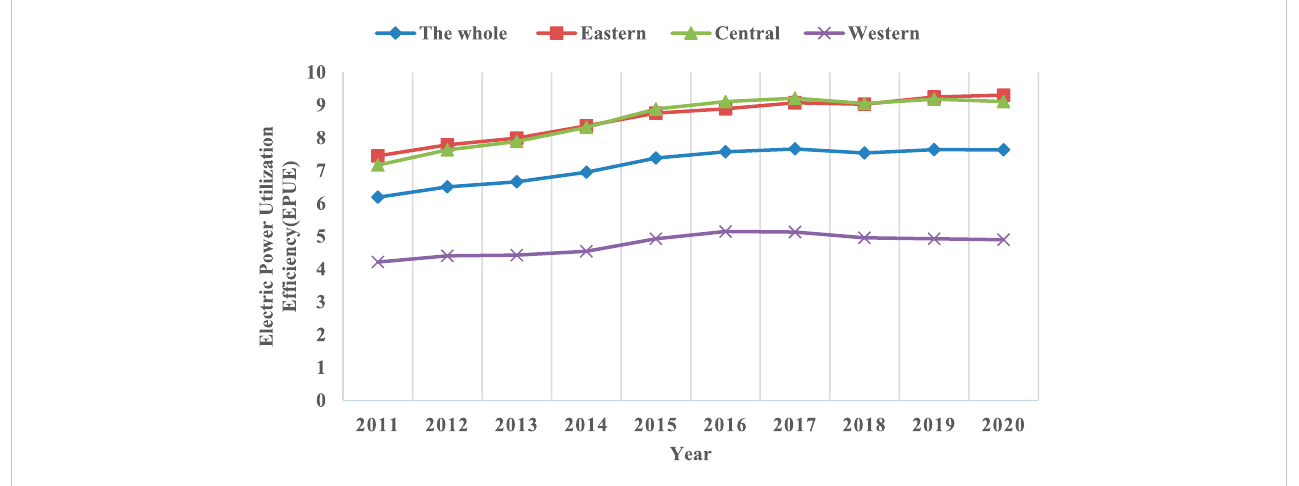
FIGURE 1 The whole of China and regional electric power utilization ef fi ciency from 2011 to 2020 (Ten thousand Yuan/Ton coal